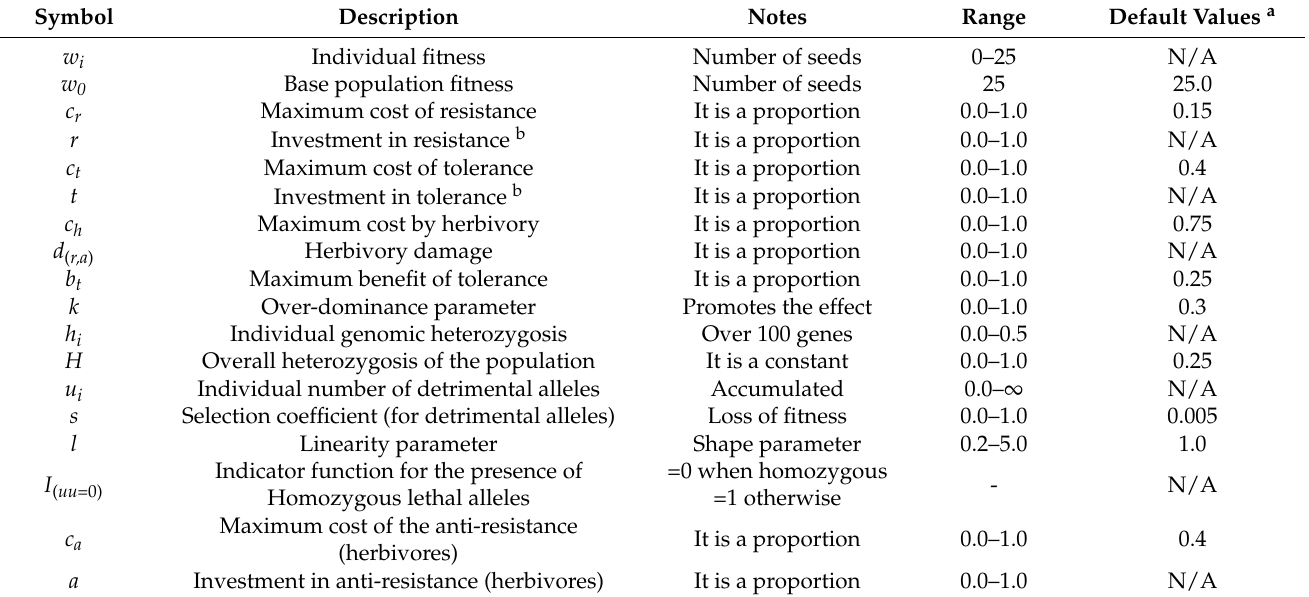
Table 3. Symbols in Equations (1) and